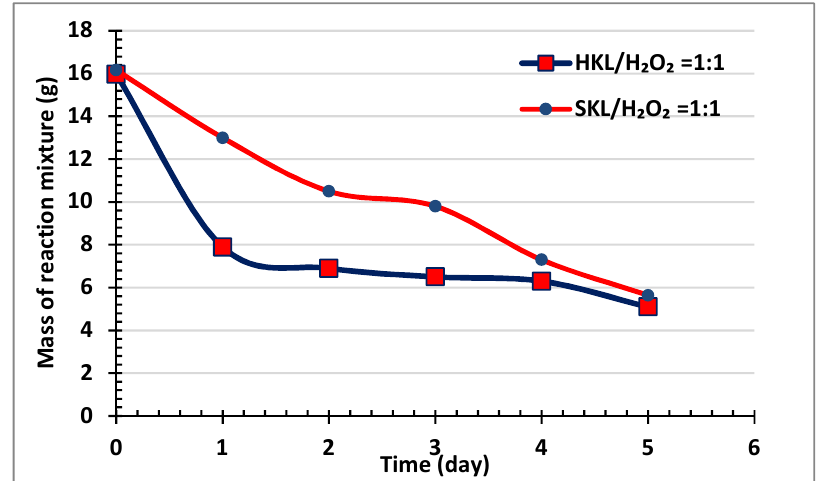
Figure 2. Mass of reaction mixture vs. treatment time. Note: in these tests, 5 g (d.b.) SKL or HKL and 10 g of 50 wt% H 2 O 2 were used.